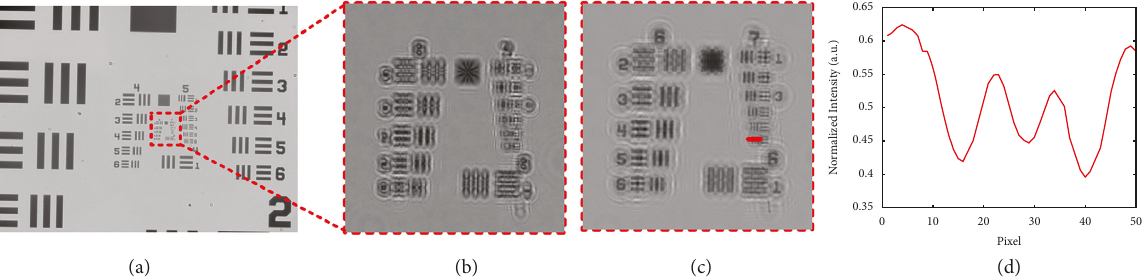
2464; (b) the raw hologram of the ×